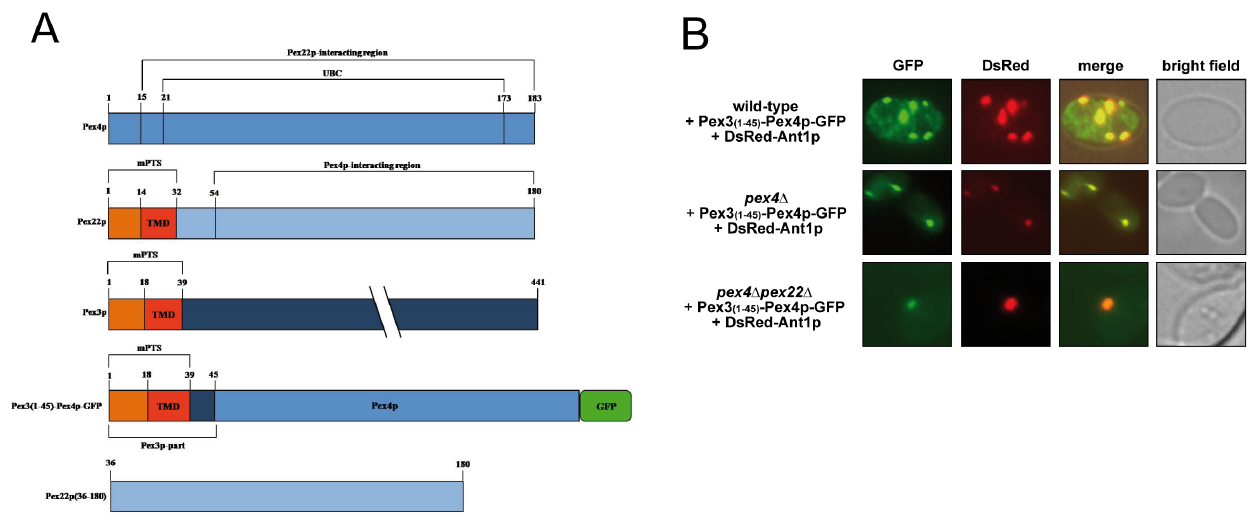
Figure 1. The Pex3(1–45)-Pex4p fusion protein binds the soluble Pex22(C)p-fragment at peroxisomes. ( a ) Schematic topological representations of full-length Pex4p and the applied chimeric and truncated versions of Pex4p, Pex3p and Pex22p. The luminal domains are shown in orange, the trans-membrane domains (TMD) in red , the cytosolic parts in blue and GFP (green fluorescent protein) in green . The membrane protein targeting signal (mPTS), the ubiquitin-conjugating domain (UBC) as well as numbers of important amino acid positions are denoted. Note: While the domains of Pex22p, Pex4p and Pex3p are depicted at the same scale, the size of GFP (green fluorescent protein) is reduced in this model. ( b ) Peroxisomal targeting of a chimeric Pex3(1–45)-Pex4p. Intracellular localization of chimeric Pex4p in wild-type and indicated pex -mutant cells is monitored by fluorescence microscopy. Pex4p is usually anchored to peroxisomes via binding to the C-terminal part of the peroxisomal membrane protein Pex22p. Colocalization of the GFP-tagged chimeric Pex3p(1–45)-Pex4p with the DsRed-tagged peroxisomal membrane marker Ant1p indicates that it localized to peroxisomes in all strains.